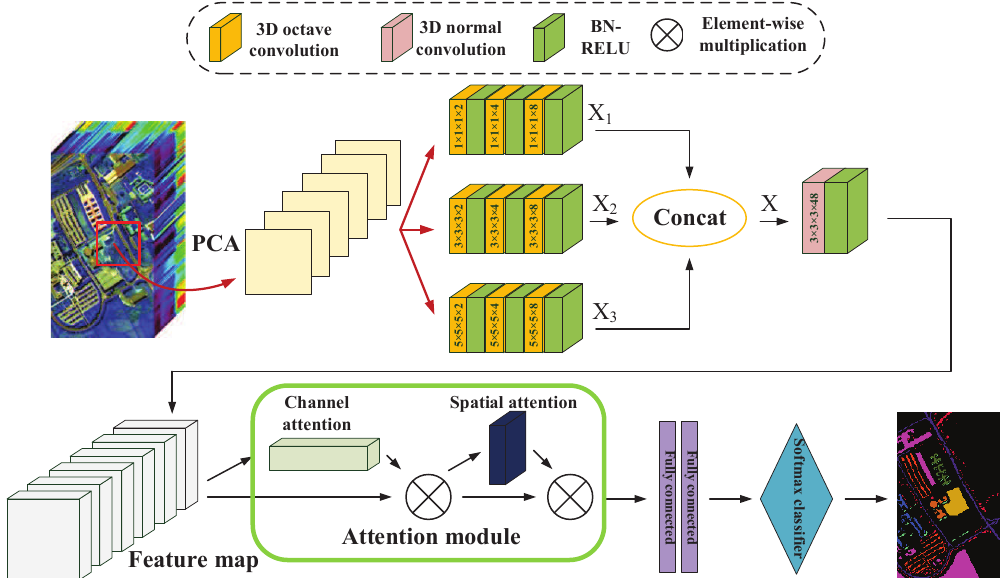
Figure 3. The overall flowchart of the proposed method. (Top) Using principal component analysis (PCA) and octave 3D CNN to extract features. (Bottom) Utilizing the channel and spatial attention module to refine features and finally to